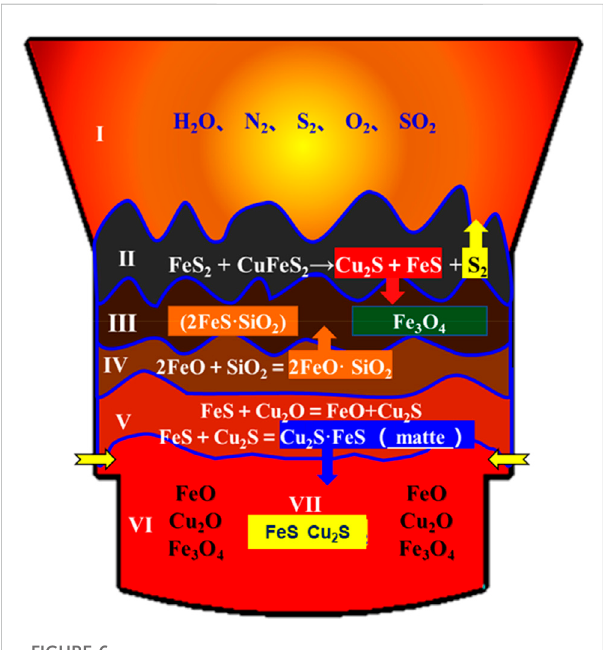
FIGURE 6 Mechanism model of oxygen side blowing copper smelting.